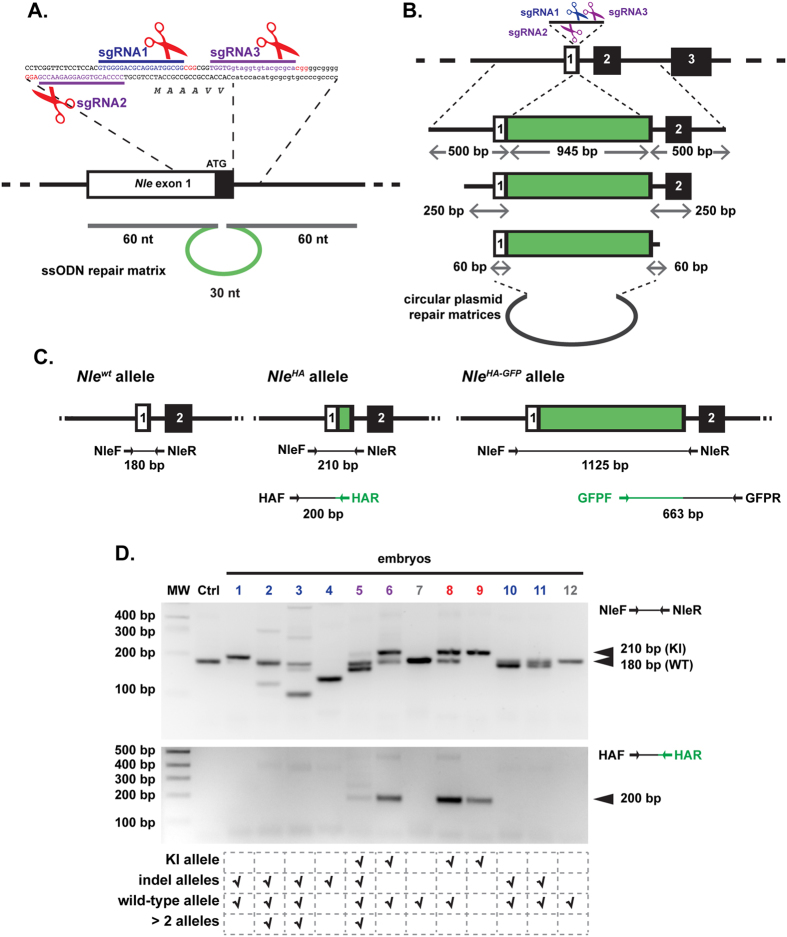
CRISPR/Cas9 genome editing strategy and mutation detection at the Nle exon 1 region.(A) Schematic representation of the Nle exon 1 region, sgRNAs sequences and ssODN repair matrix. The coding part of Nle exon 1 is indicated in black. The sgRNA-targeting sequences are underlined, and the protospacer adjacent motif sequences are labelled in red. Cas9 nuclease cuts DNA at position −3 bp from the protospacer adjacent motif. The ssODN repair matrix contains 60 nucleotides of homology flanking both sides of the DSB generated by sgRNA1. (B) Schematic representation of the dsDNA matrices used in this study. (C) Schematic representation of Nlewt, NleHA and NleHA-GFP alleles. Positions of the primers and sizes of the PCR fragments are indicated below each allele. (D) Agarose gel electrophoresis analysis of PCR products of one non-injected embryo (Ctrl) and twelve embryos (lanes 1 to 12) microinjected into the pronucleus with Cas9 mRNA/sgRNA1/ssODN (100 ng/μl/50 ng/μl/20 ng/μl) and cultured for 72 hours. The interpretation of the PCR profiles is given below the gel. Embryo n° 12 has no edited allele and was considered wild-type. Some embryos displayed more than 2 alleles and were considered mosaic (n° 2, 3 and 5). Only the KI allele was detected in embryo n° 9 which was considered homozygous for the KI allele. MW: 100 bp molecular weight marker. Embryos with no mutations, indels, KI allele and both KI allele and indels are labelled in gray, blue, red and purple respectively.